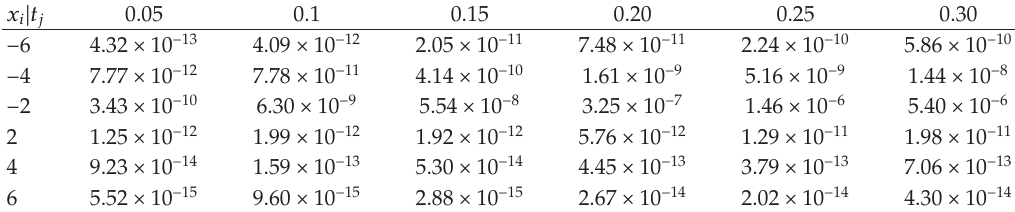
Figure 6: (cid:2) a (cid:3) The obtained u HAM for system (cid:2) 1.3 (cid:3) using 10-term approximation. (cid:2) b (cid:3) The obtained v HAM for system (cid:2) 1.3 (cid:3) using 10-term approximation. h (cid:8) − 0 . 7. Table 1: Absolute errors regarding u (cid:2) x,t (cid:3) for system (cid:2) 1.1 (cid:3) with N (cid:8) 10.